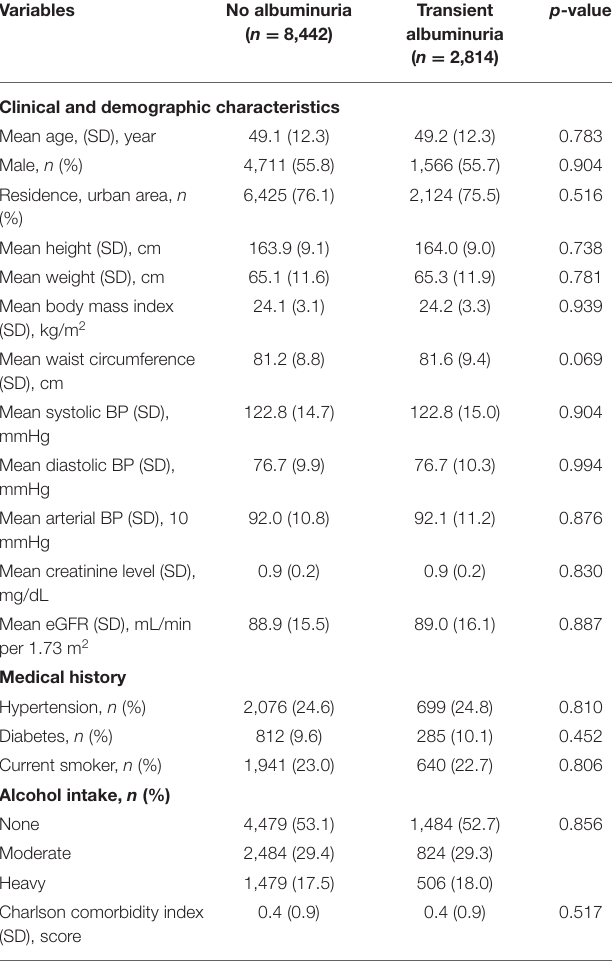
TABLE 3 | Baseline characteristics after propensity score matching between the transient albuminuria and no albuminuria groups.